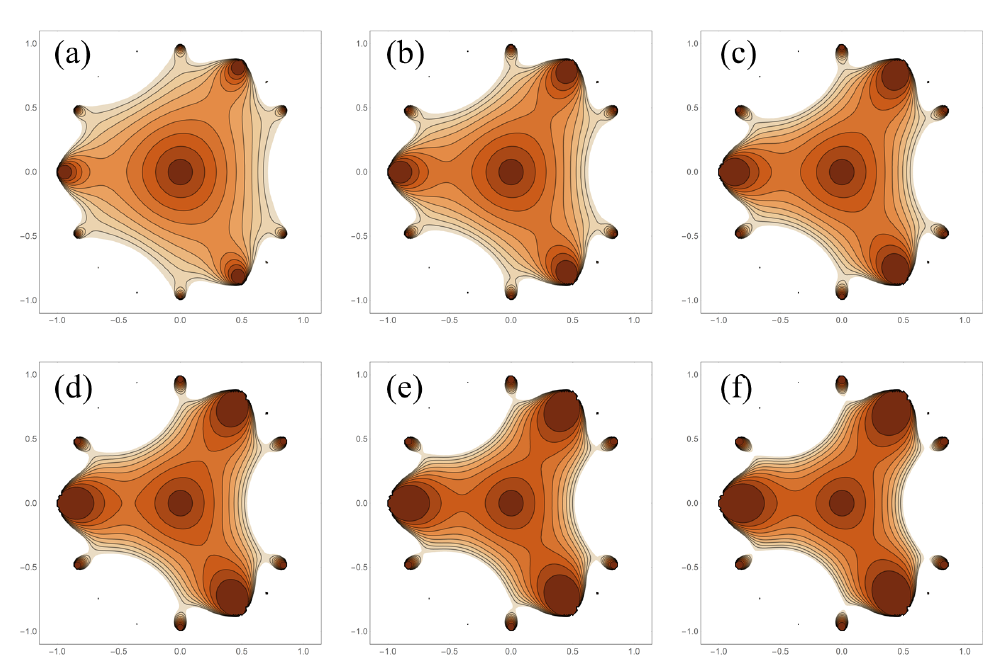
( 3 ) ( z ) (( a ) through ( f ) respectively). 10